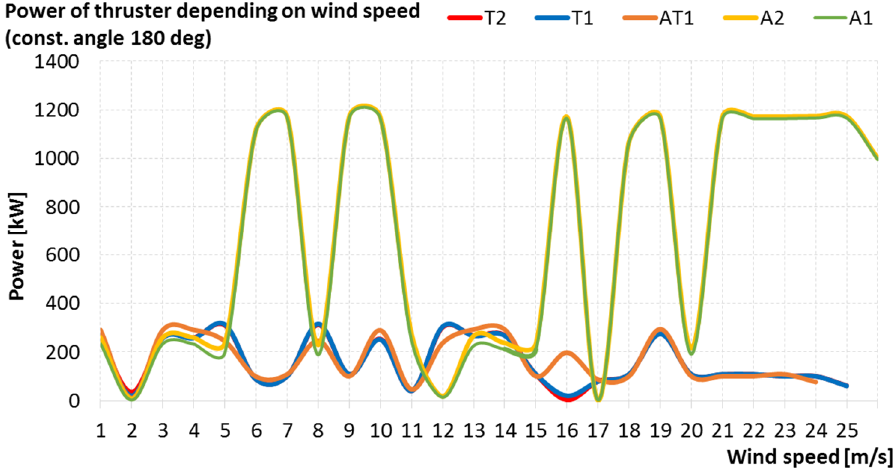
Figure 9. The power of individual thrusters depending on the wind speed (180 deg. angle).